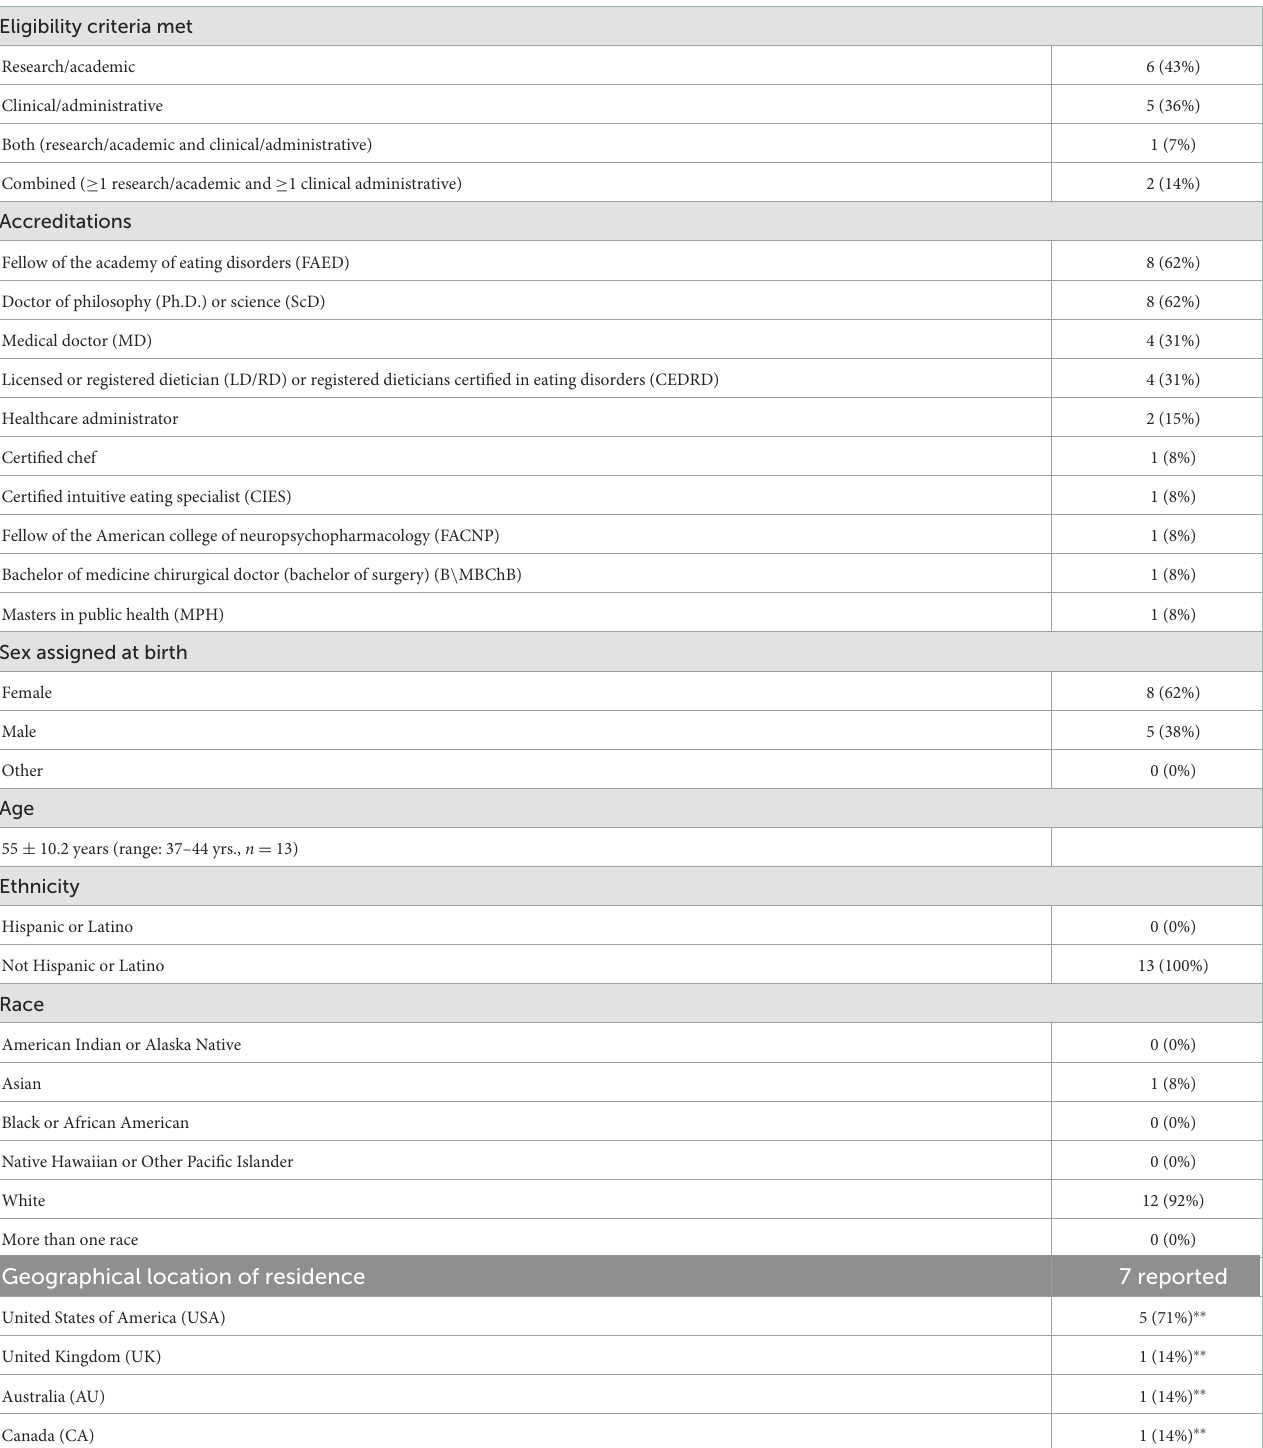
TABLE 3 Characteristics of the 13/14 study participants who provided demographic